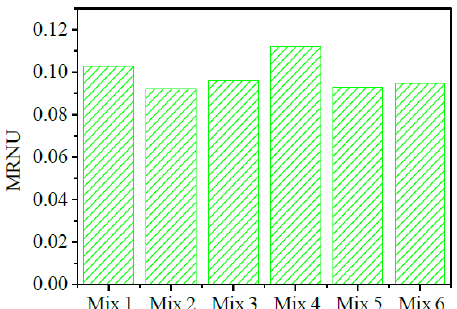
Figure 9. Material removal non-uniformity (MRNU) compared un- der different mixes.